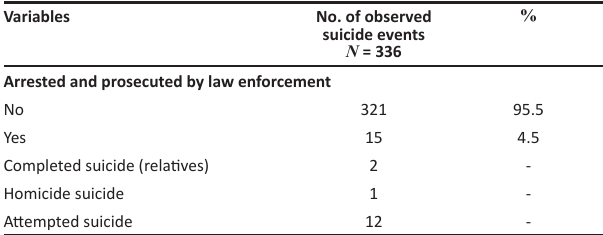
TABLE 2: Characteristics of suicide events as reported by media reports of Nigerian news media from January 2016 to December 2019.